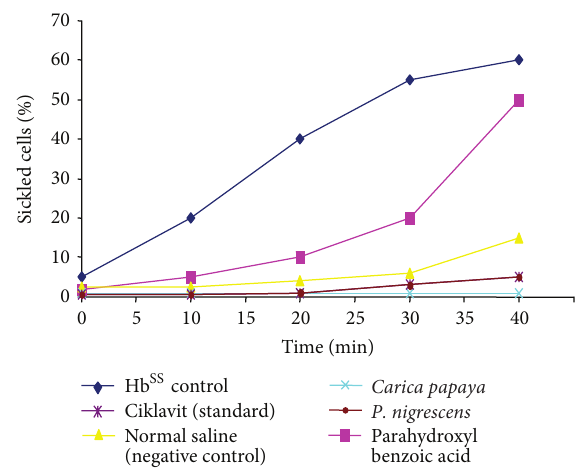
Figure 7: Comparison of antisickling activities of phytomedicines.